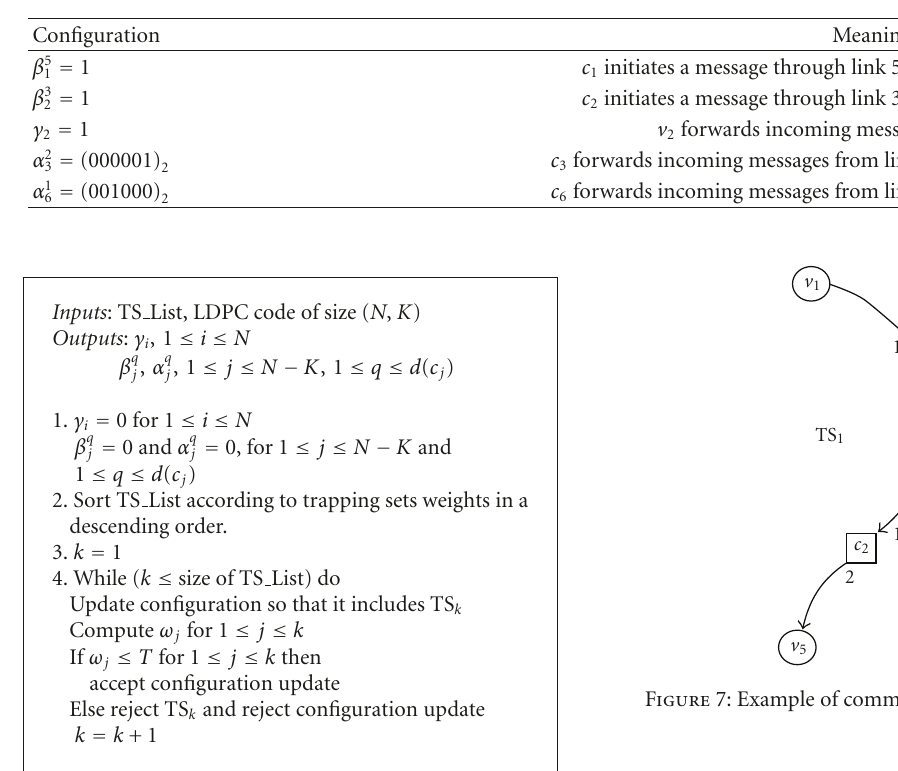
Table 2: Nodes configuration for T (4,2).